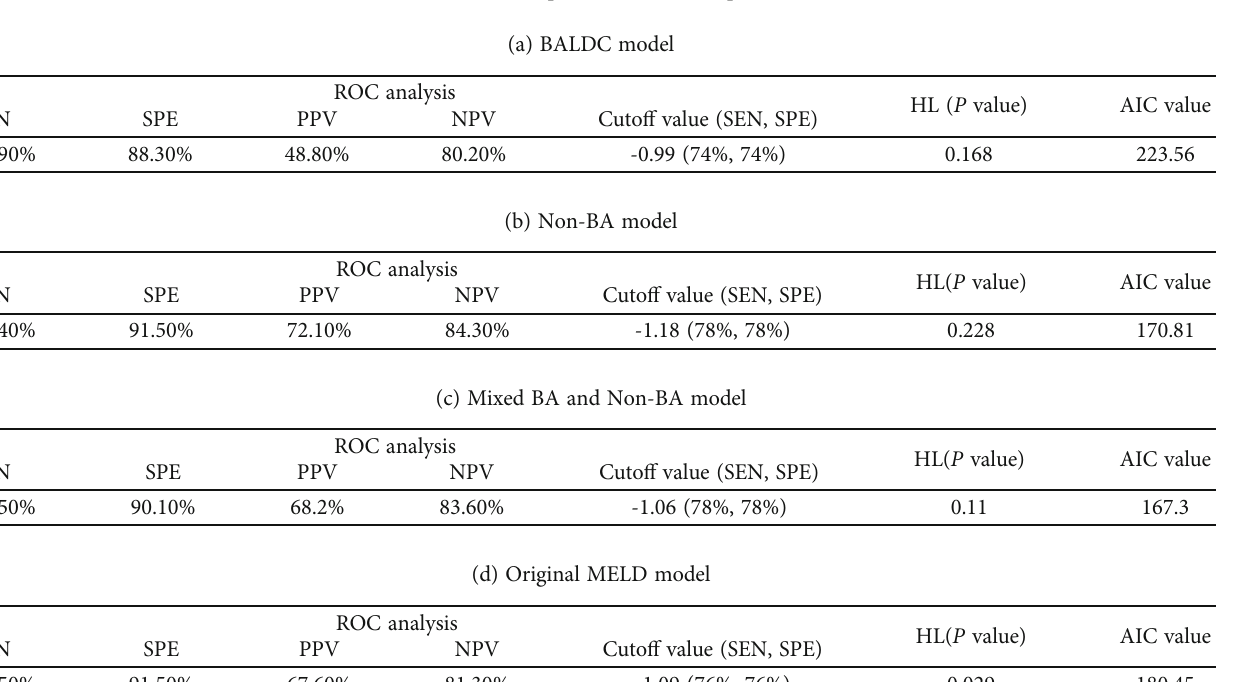
Table 6: Model comparisons for ascites prediction.